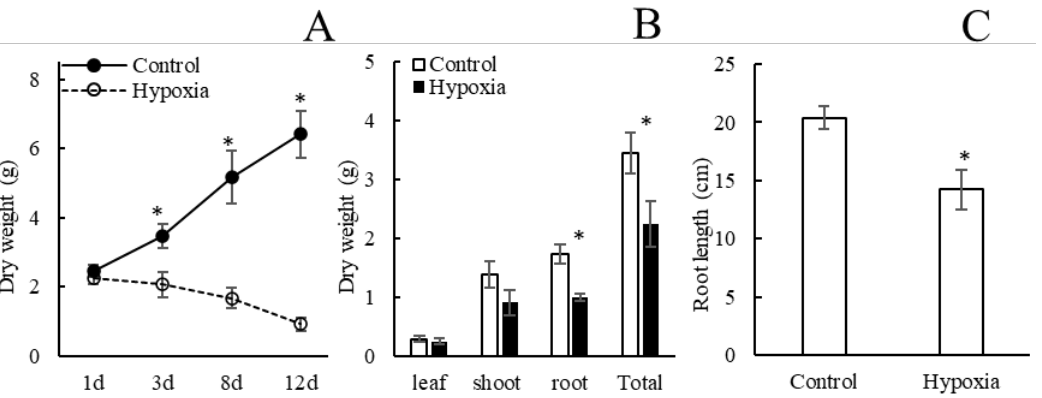
Figure 1. Total plant dry weight change of different hypoxia treatment durations ( A ), dry weight of different part of plants ( B ) and root length ( C ) of control plants and in plants subjected to hypoxia for three days. Means ± SE are shown ( n = 6 – 8). Asterisks indicate a difference between aerated and hypoxia ( p ≤ 0.05 denoted by *; t -test).